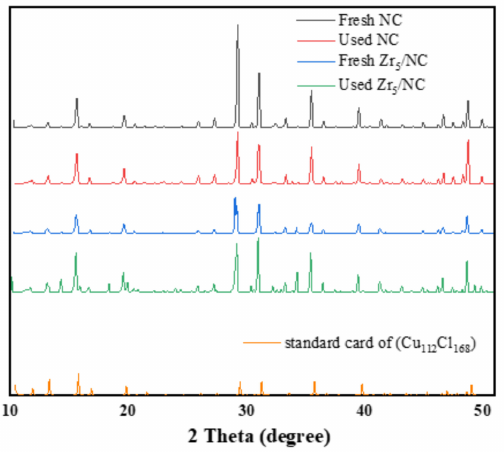
Figure 5. XRD spectra. Standard card of Cu 112 Cl 168 : Cambridge Crystallographic Data Centre (CCDC) and the deposition number is